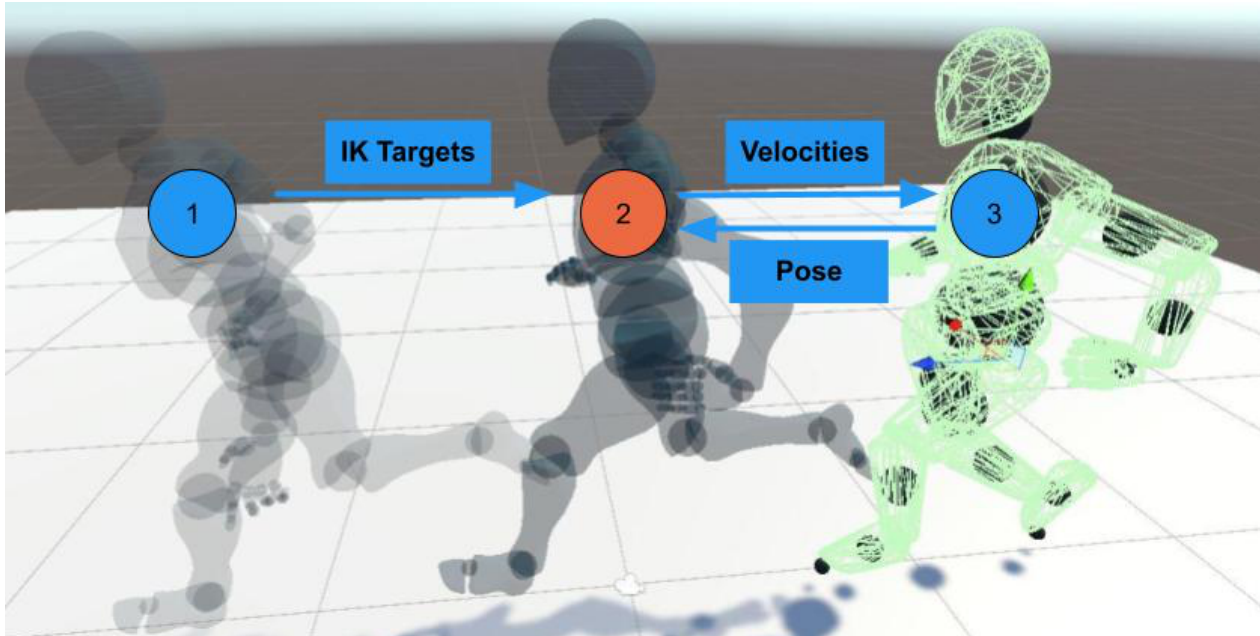
Figure 4. VR embodiment stages overview. The 3 stages for the physical embodiment system. 1: user tracking, 2: pose and velocity computation, 3: physical avatar being